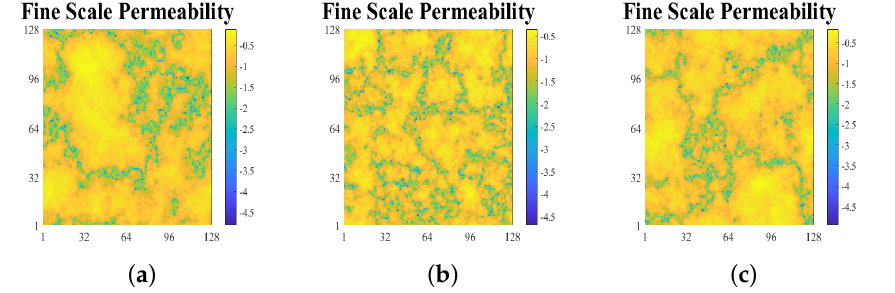
Figure 8. ( a ) Sample input data of permeability field “a” on a 128 × 128 grid used for training the neural network. ( b ) Sample input permeability field “b” on a 128 × 128 grid used for training the neural network. ( c ) Sample input permeability field “c” on a 128 × 128 grid used for training the neural network.